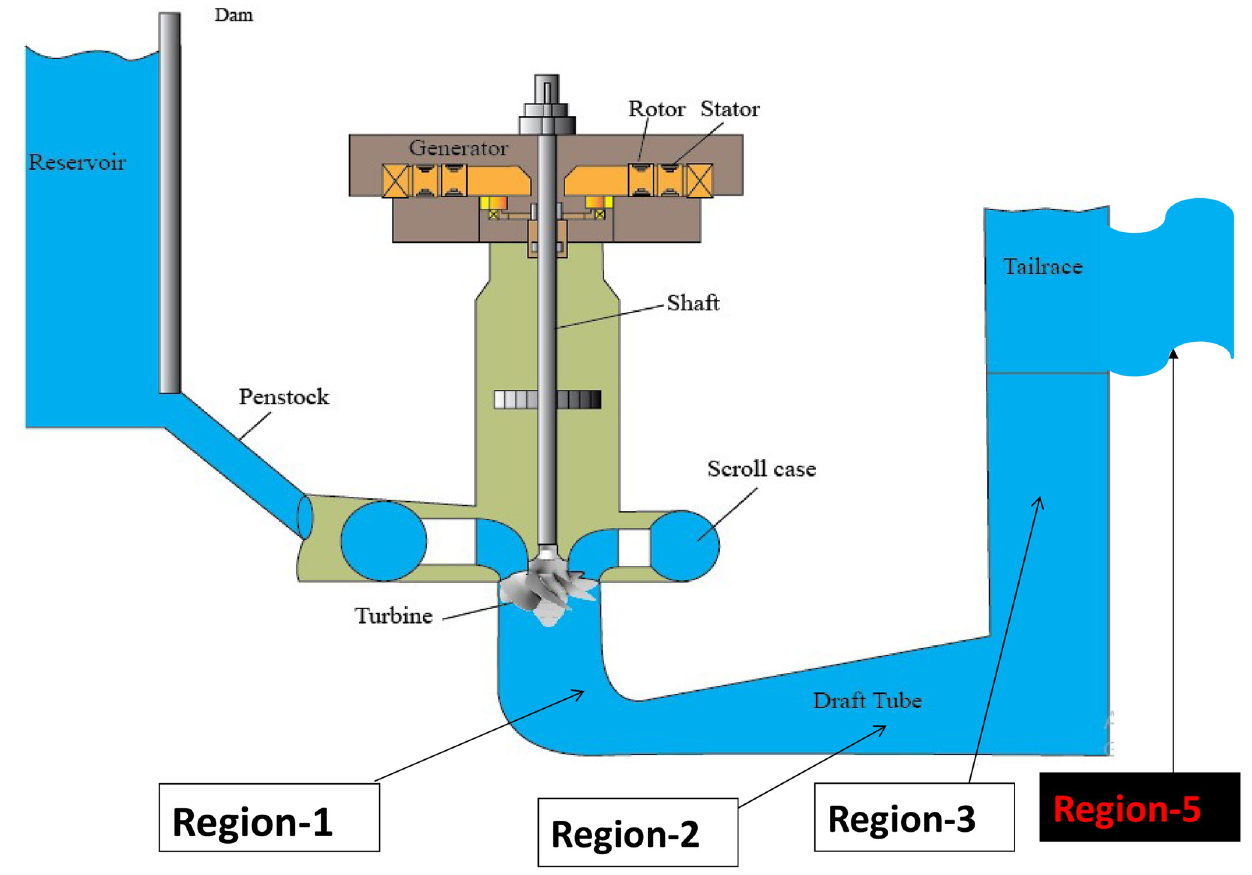
Fig 3. Unit-4 model of Karnafuli Hydroelectric Power